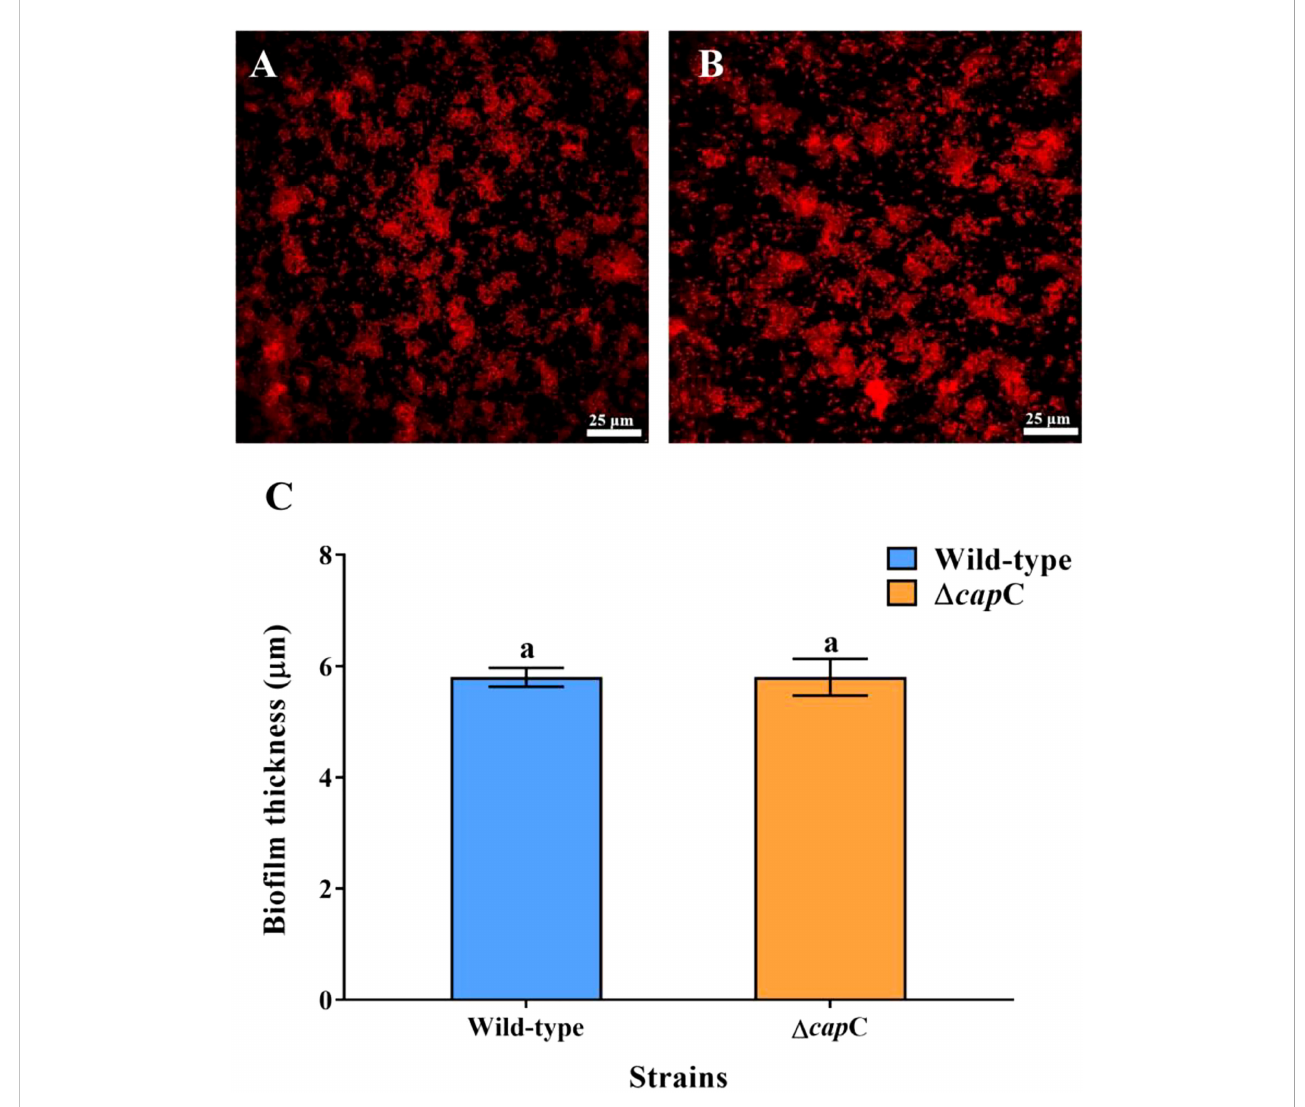
FIGURE 4 Bio fi lm-forming ability of experimental strains. (A, B) The CLSM images of wild-type and D capC bio fi lms. (C) Quantitative results of bio fi lm thickness of wild-type and D capC bio fi